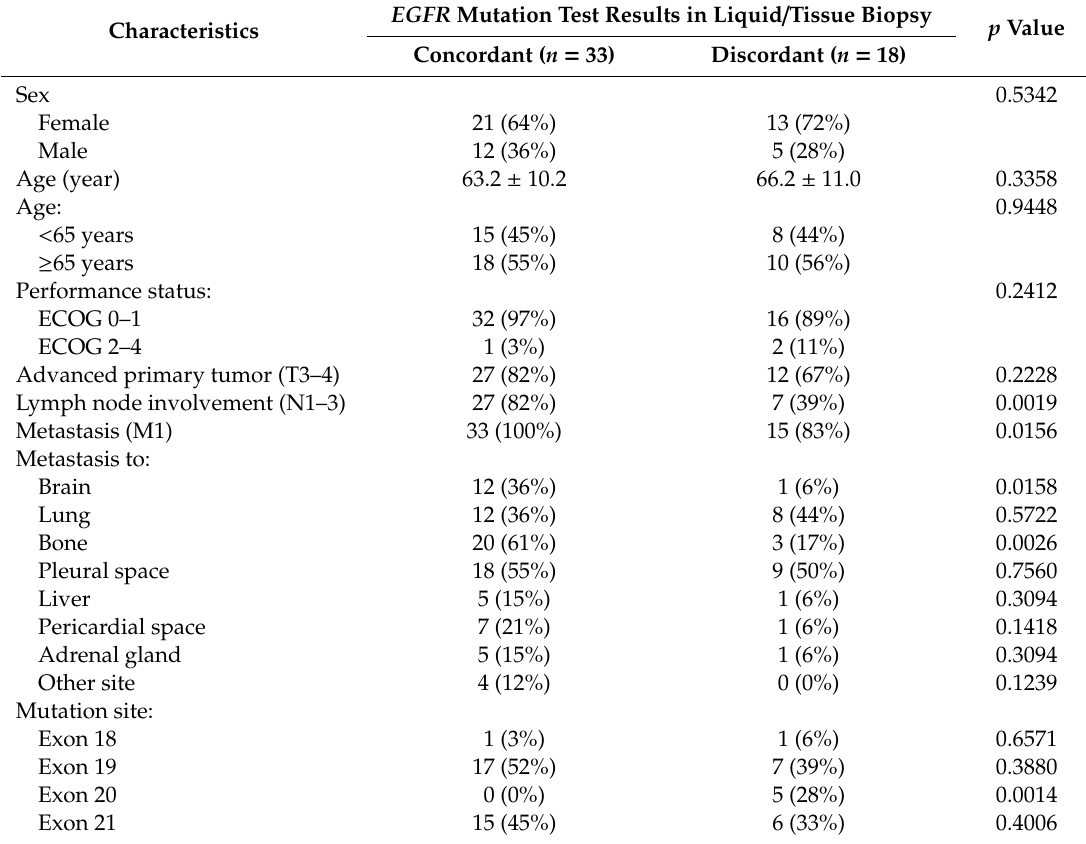
Table 1. Baseline characteristics of the study population, stage III or IV lung adenocarcinoma patients having EGFR mutations detected in the tissue samples. EGFR Mutation Test Results in Liquid / Tissue Characteristics